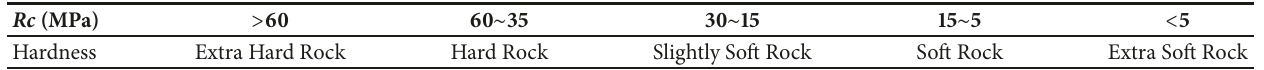
Table 8: The correspondence relationship of rock uniaxial compressive strength Rc and rock